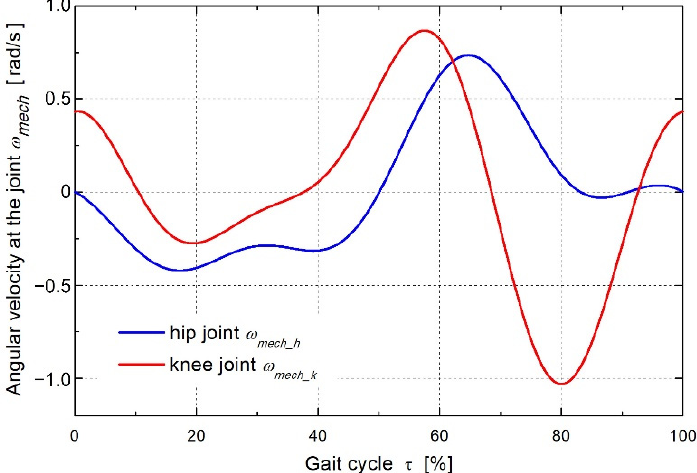
Figure 15. The required angular velocity course at the driven joints for step length of l = 0.7 m.